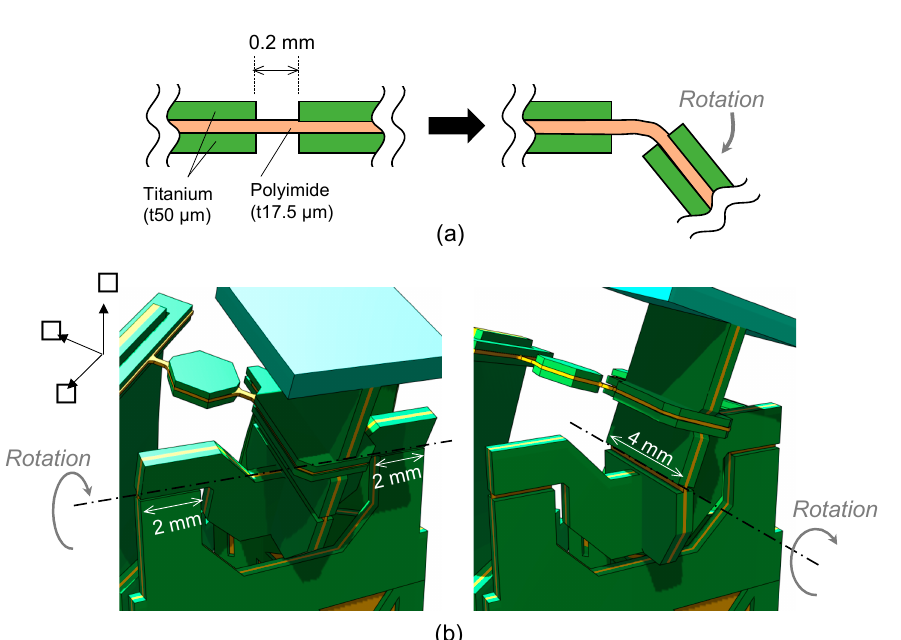
Figure 3. 2-DoF hinge structure. ( a ) Cross-sectional image of hinge, and ( b ) 2-DoF hinge design and its motion.